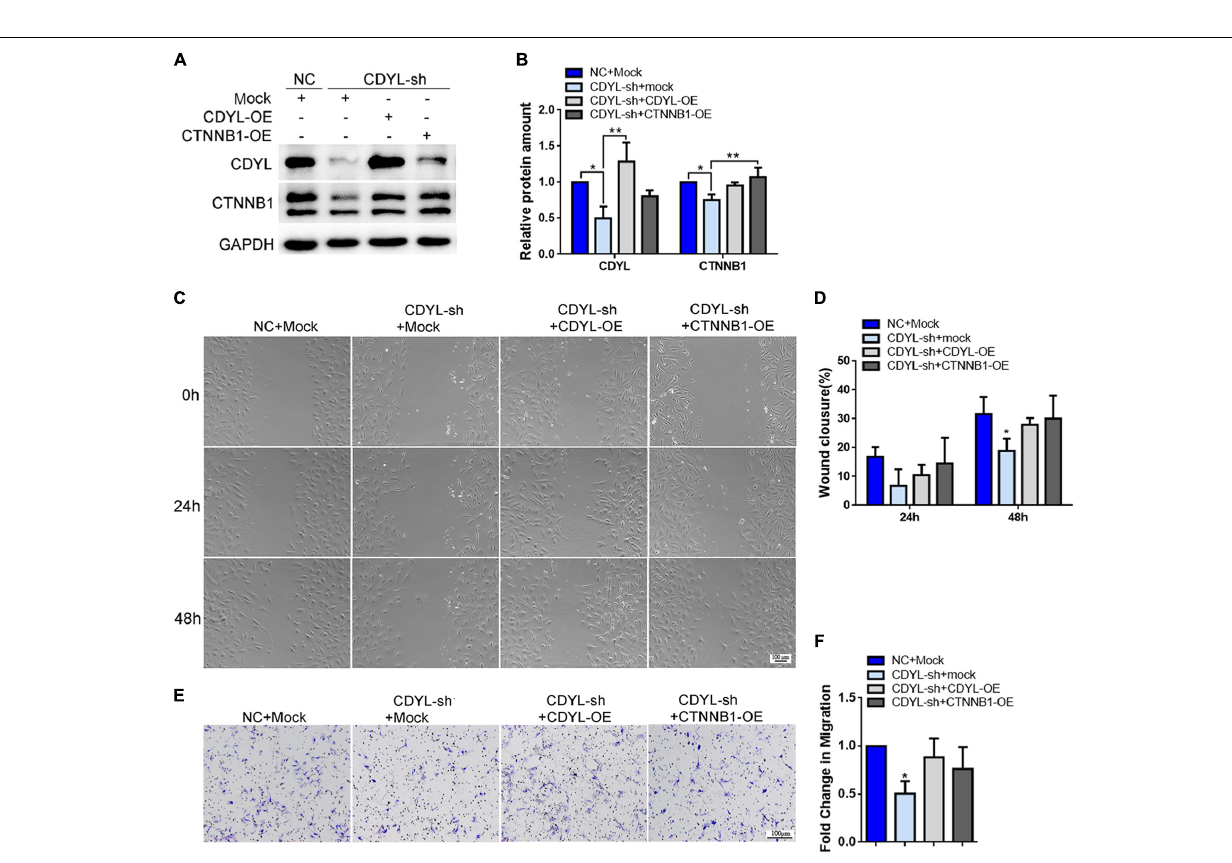
Frontiers in Cell and Developmental Biology |